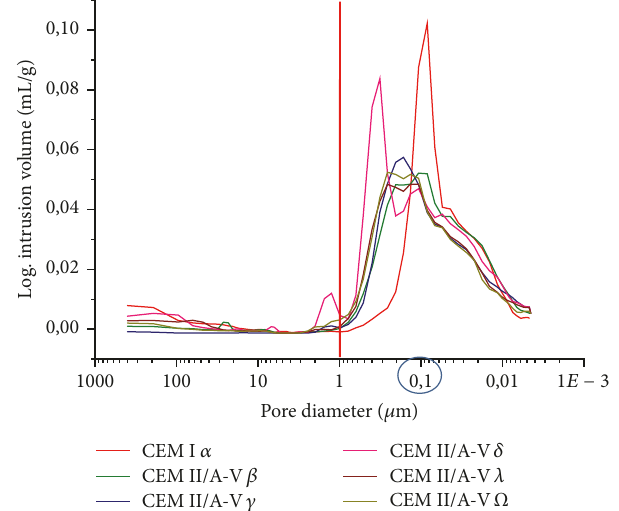
Figure 5: Mercury intrusion porosimetry (MIP) results at seven days.